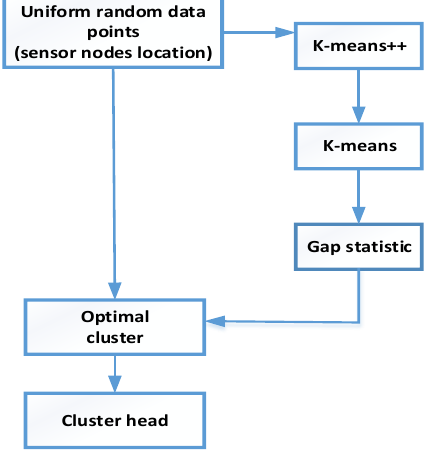
Figure 5. Combination of the three clustering algorithms